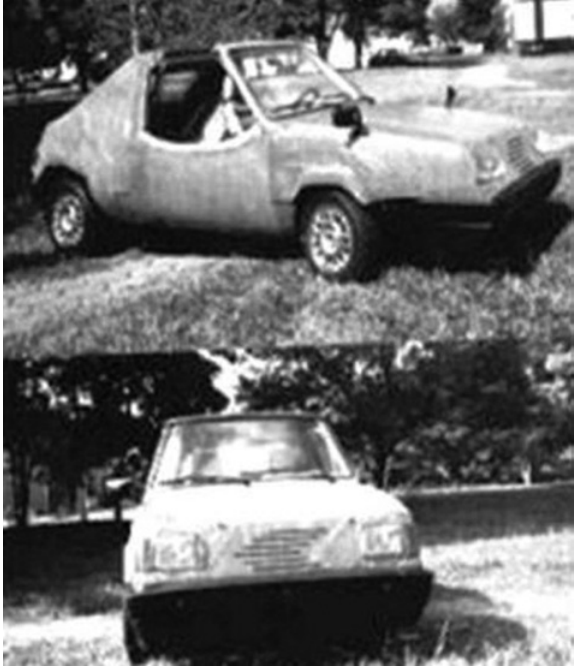
Figure 15: A car made from jute fiber-reinforced composite and hybrid composites